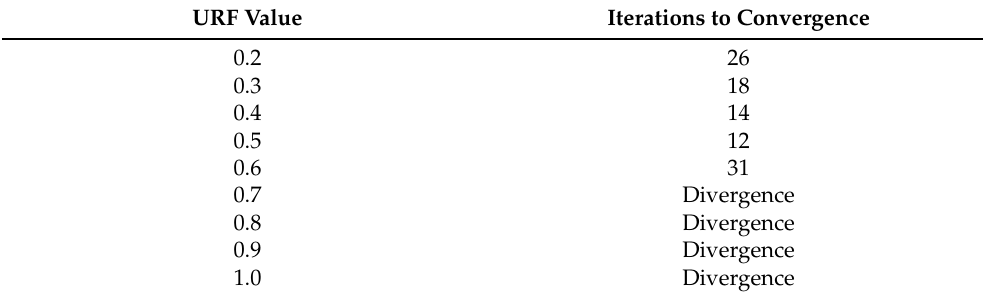
Table 7. URF values’ influence on the convergence of the FSI algorithm.